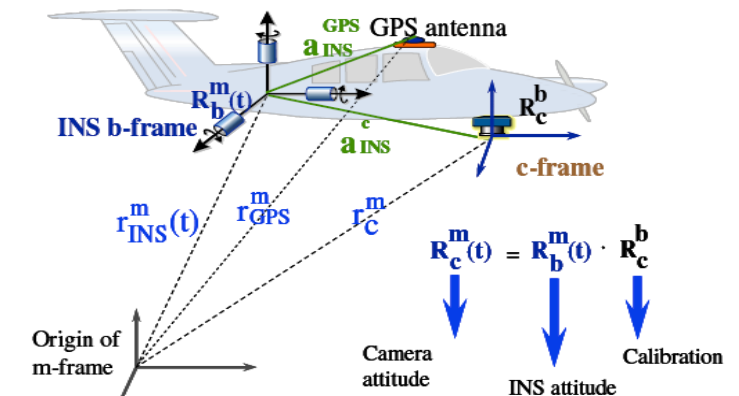
Figure 6. Concept of boresight angle